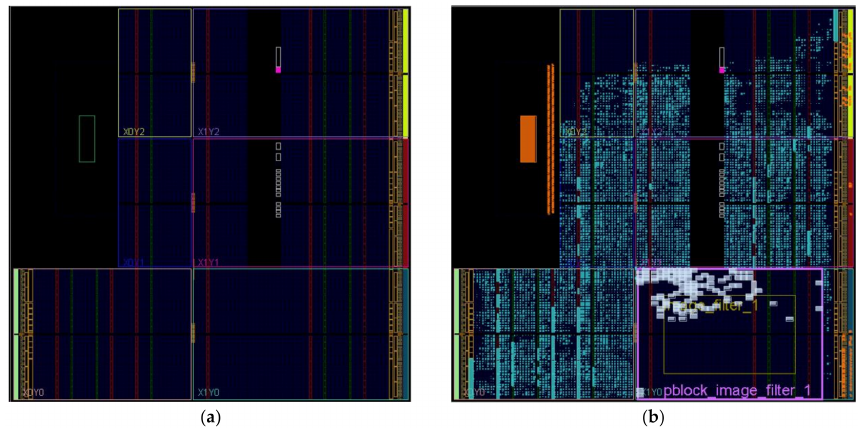
Figure 5. The representation of the chip’s resources utilization: before ( a ) and after ( b ) the implementation